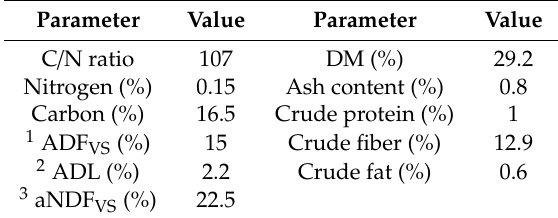
Table 3. Composition of non-ensiled energy cane FM of lot B.